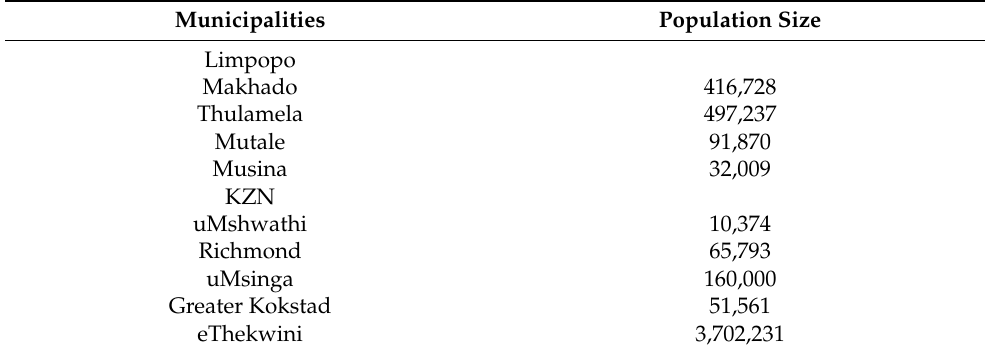
Table 1. Population size of local municipalities surveyed in KwaZulu-Natal (KZN) and Limpopo provinces. Municipalities Population Size Limpopo Makhado 416,728 Thulamela 497,237 Mutale 91,870 KZN uMshwathi 10,374 Richmond